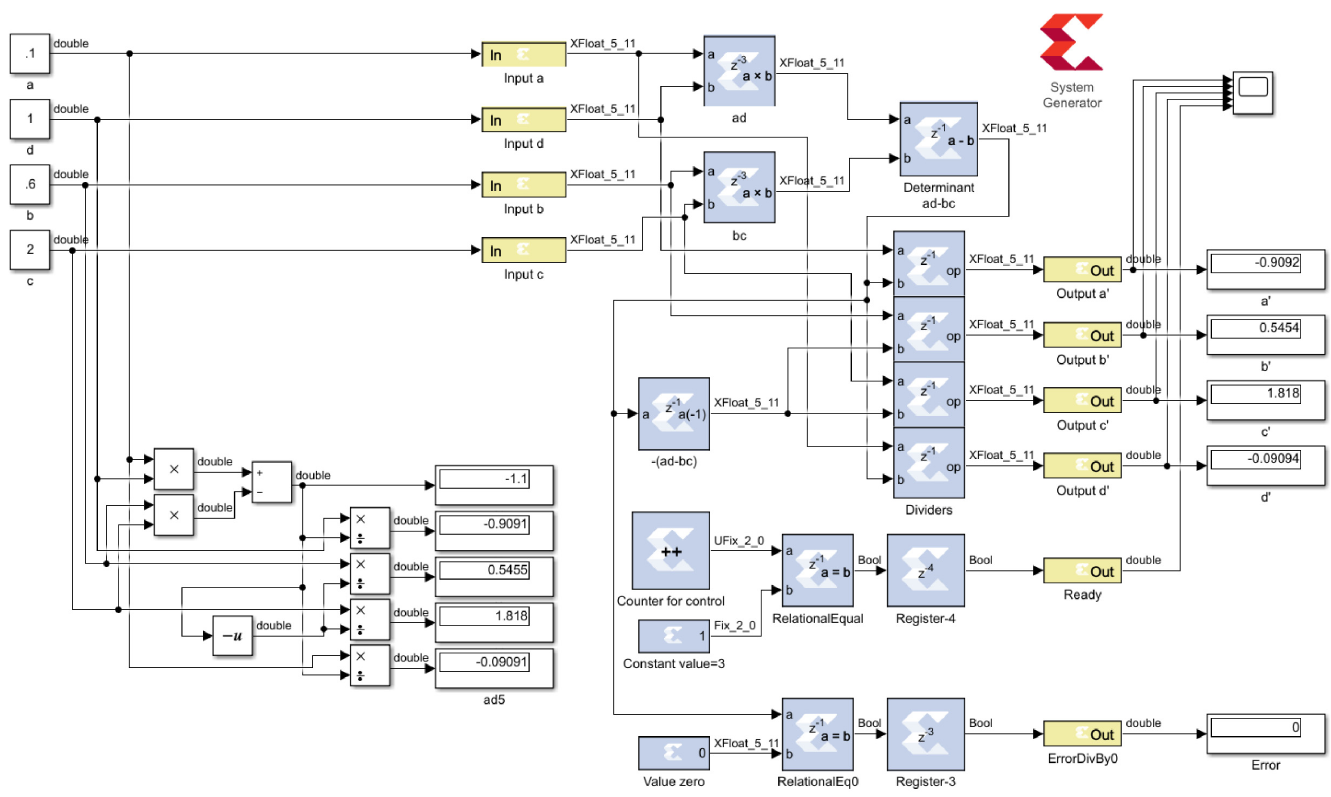
Fig 3. Proposed architecture. Architecture for computation of a 2 × 2 inverse matrix using the full unrolling technique.